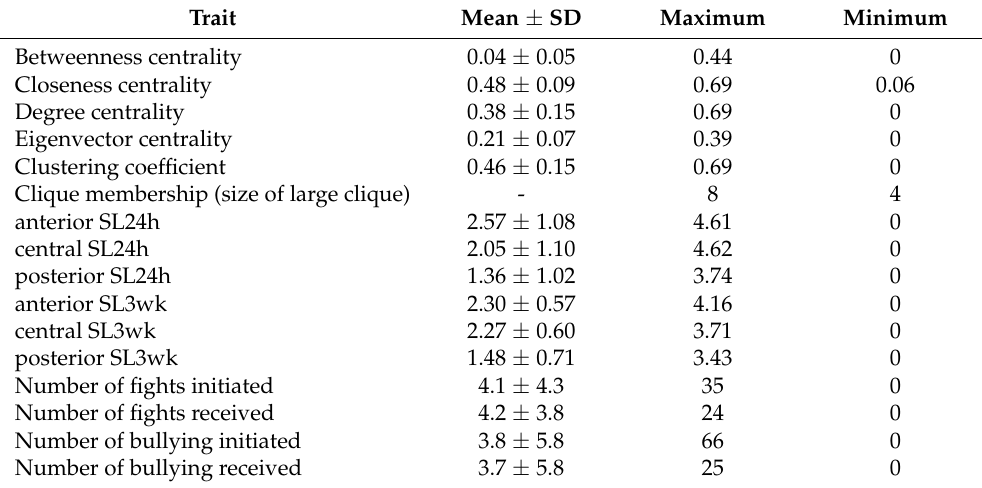
Table 2. Descriptive statistics for the transformed aggressive social network traits, skin lesion traits and the number of fights and bullying behaviours.